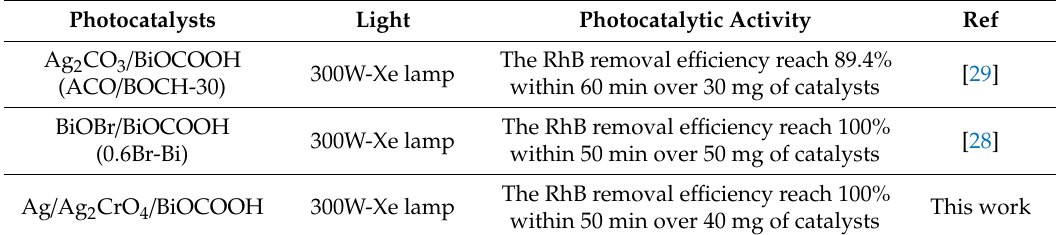
Table 1. The photocatalytic degradation parameters by di ff erent BiOCOOH-based photocatalysts. Photocatalysts Light Photocatalytic Activity